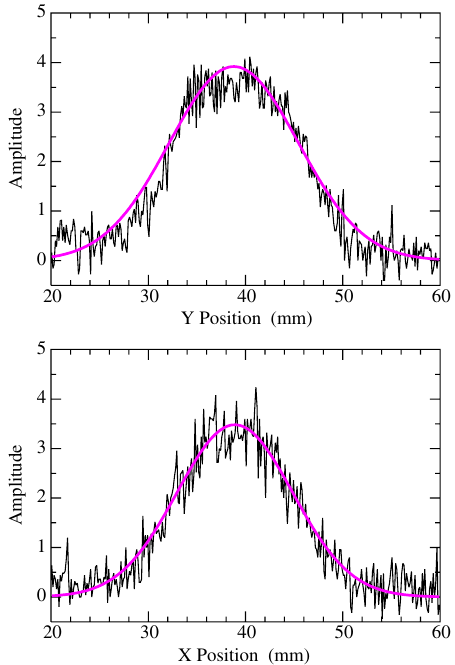
FIG. 4. Measurements of the vertical (top) and horizontal (bottom) beam profiles for an uncooled beam. The purple curves represent Gaussian fits to the profile shape.